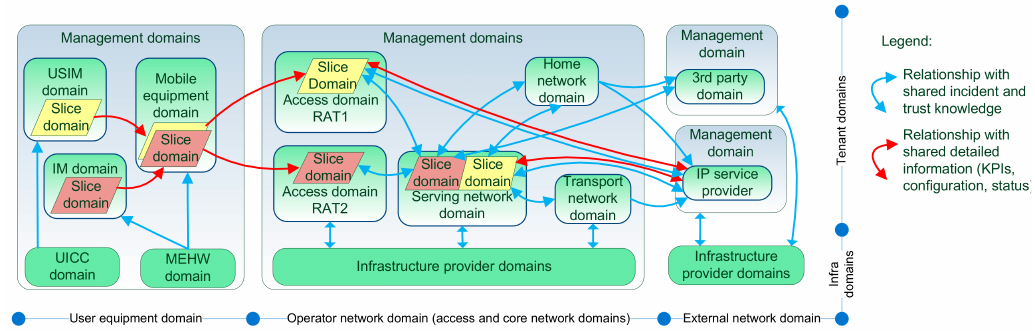
Figure 2. Fifth generation (5G) security architecture (adapted from [11,12]) reflecting security monitoring information that is shared across domains. USIM: user subscriber identity module; RAT: Radio